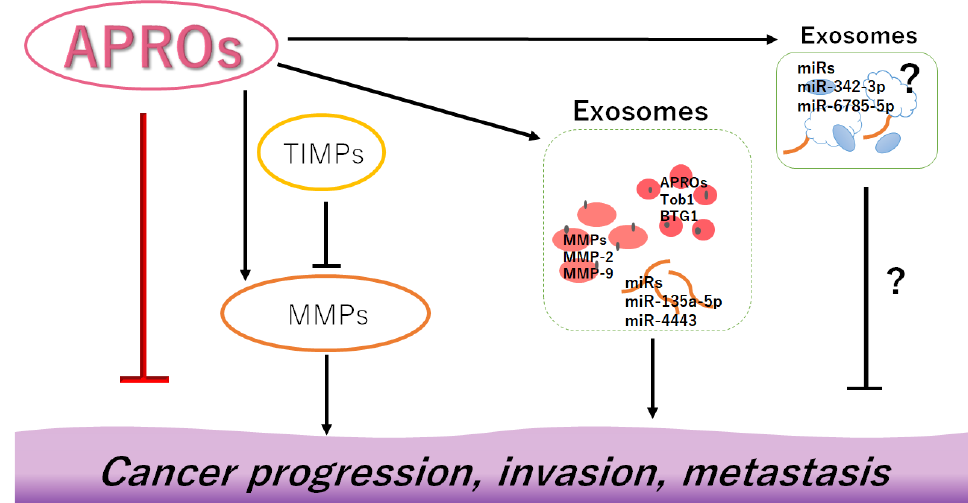
Figure 2. Although APRO family proteins (APROs) could individually inhibit the progression, in- vasion, and/or metastasis of cancer cells, the other conditions such as the expression levels of MMPs or TIMPs, the presence of some exosomes, and/or the function of microRNAs (miRNAs) or specific proteins in the exosomes could further alter the effect of APRO proteins, either of promotion or inhibition, on the invasiveness of cancer cells. Indicated molecules are examples. Arrowhead means stimulation, whereas hammerhead represents inhibition. Note that some critical pathways